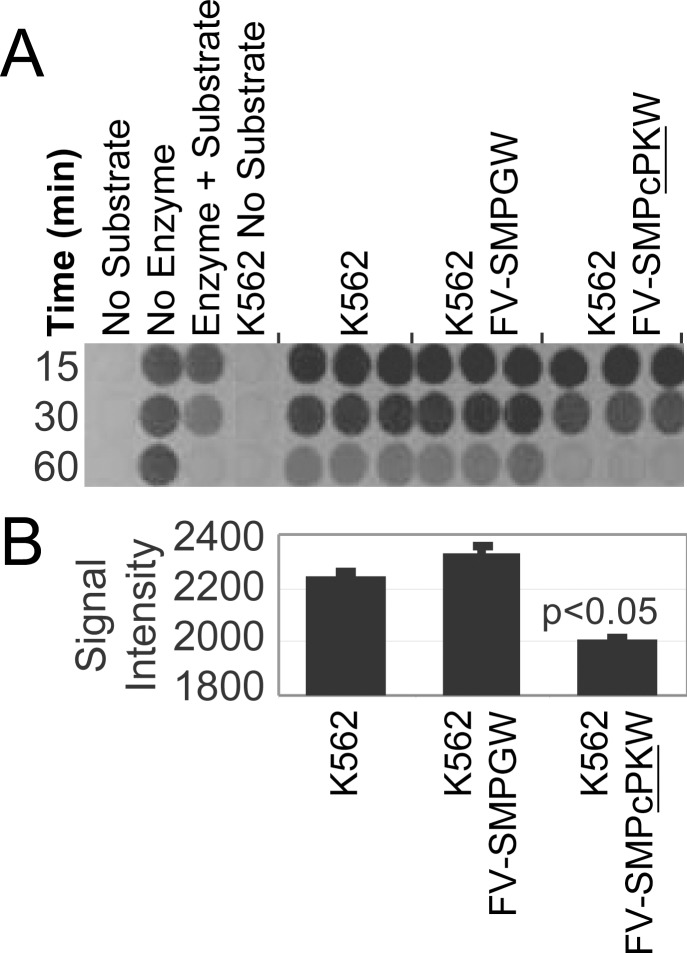
PK expression from FV vectors.
a) Fluorometric assay for pyruvate kinase expression from the foamy canine PK vector FV-SMPcPKW. The presence of pyruvate kinase enzyme is detected by the conversion of fluorescent NADH to non-fluorescent NAD+. In this assay adenosine diphosphate (ADP) and phosphoenolpyruvate are converted to adenosine triphosphate (ATP) and pyruvate by pyruvate kinase (PK). Pyruvate and fluorescent NADH are then converted to lactate and non-fluorescent NAD+ by lactate deydrogenase as indicated by a reduction in fluorescence over time from 15 minutes to 60 minutes. “No Substrate” is no PK assay components, “No Enzyme” is all assay components but no positive control of purified PK enzyme. “Enzyme + Substrate” is all assay components with purified PK enzyme as a positive control with no cell lysate. “K562 No Substrate” is K562 cell lysate with lactate dehydrogenase but no phosphoenolpyruvate, ADP or NADH. “K562” is K562 cell lysate with all assay components in triplicate. “K562 FV-SMPGW” is cell lysate from K562 cells transduced with the negative control vector FV-SMPGW that does not express PK with all assay components in triplicate. “K562 FV-SMPcPKW” is cell lysate from K562 cells transduced with the vector FV-SMPcPKW that expresses canine PK with all assay components in triplicate. In K562 cells transduced with the FV vector expressing canine PK there is a more rapid reduction in fluorescence compared to K562 cells or K562 cells transduced with a control FV vector that does not express PK. b) Densitometry analysis of loss of fluorescence at 30 minutes shows the FV-SMPcPKW vector that expresses canine PK significantly reduces the amount of fluorescent PK substrate relative to the control vector FV-SMPGW that does not express PK (p<0.05).